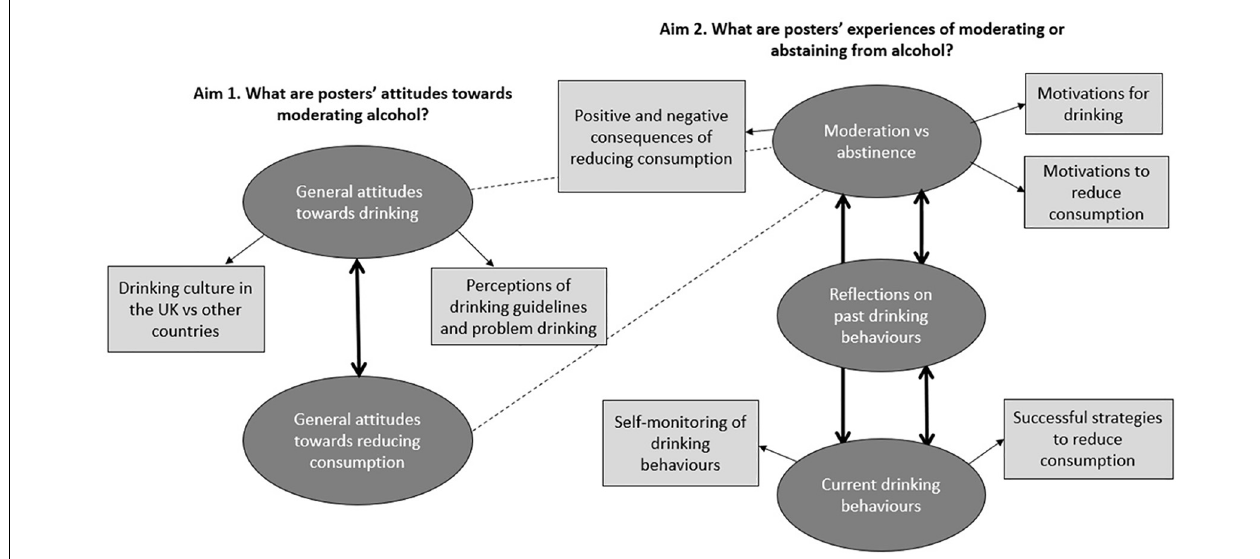
FIGURE 1 | Thematic map outlining the themes (dark grey circles) and sub-themes (light grey rectangles) for each aim. The double-ended arrows represent the linking of themes within each aim and the dotted lines represent the linking of themes across aims.